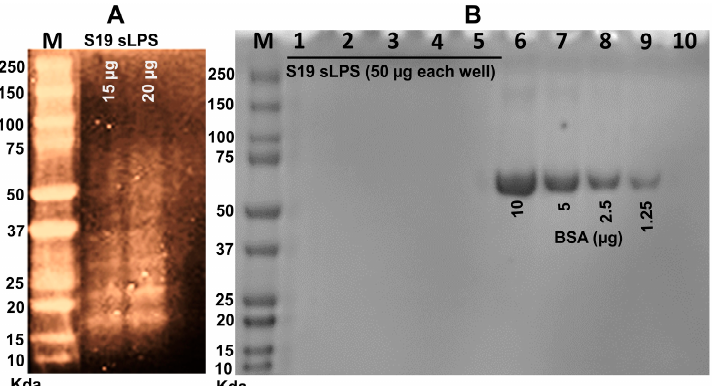
Figure 2. Electrophoretic profile of the purified B. abortus S19 sLPS. ( A ) Silver-stained SDS-PAGE image showing the S19 extracted sLPS, 15 and 20 µ g, in a smeary appearance. ( B ) Coomassie-stained SDS-PAGE showing absence of protein contaminants in 50 µ g LPS samples (Lane 1–5), detectable BSA bands as a positive control (Lane 6–9), and PBS as a negative control (Lane 10). A 10–250 Kda Precision Plus Protein Dual Color Standard (M) was used in A & B .